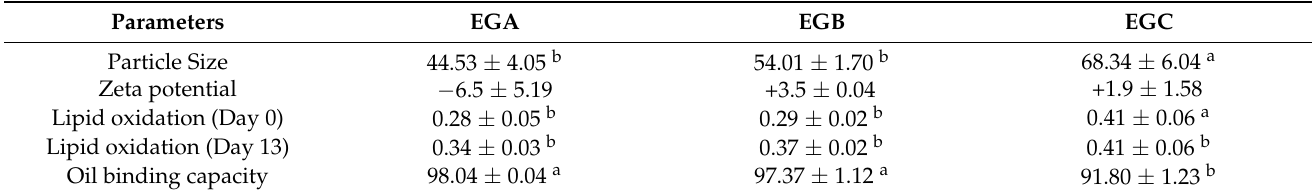
Table 3. Particle size, lipid oxidation and oil binding capacity values of EGA, EGB, and EGC.